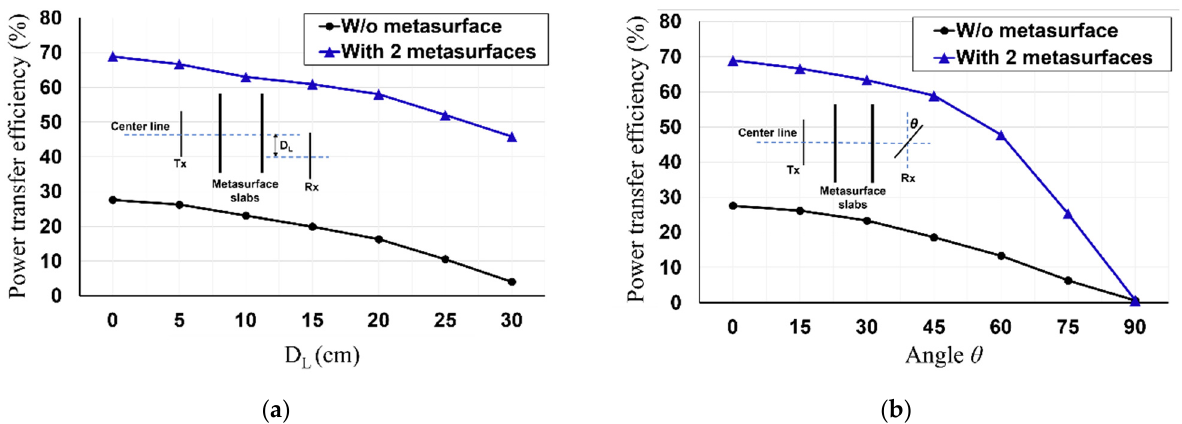
Figure 13. Measured PTE of the rollable MS-based WPT with: ( a ) lateral misalignment (D L ) at 30 cm, ( b ) angular misalignment ( θ ) at 30 cm.